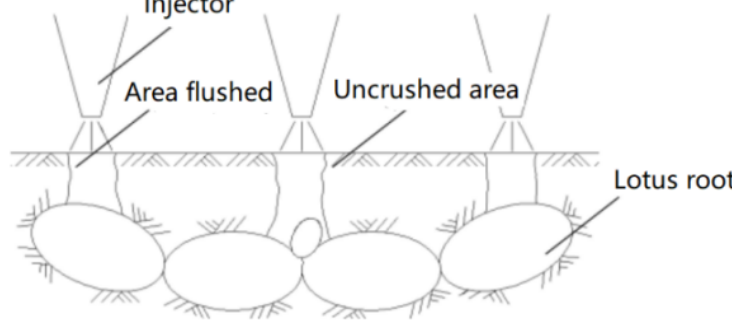
Figure 11. Status of the lotus root during hydraulic flushing process.